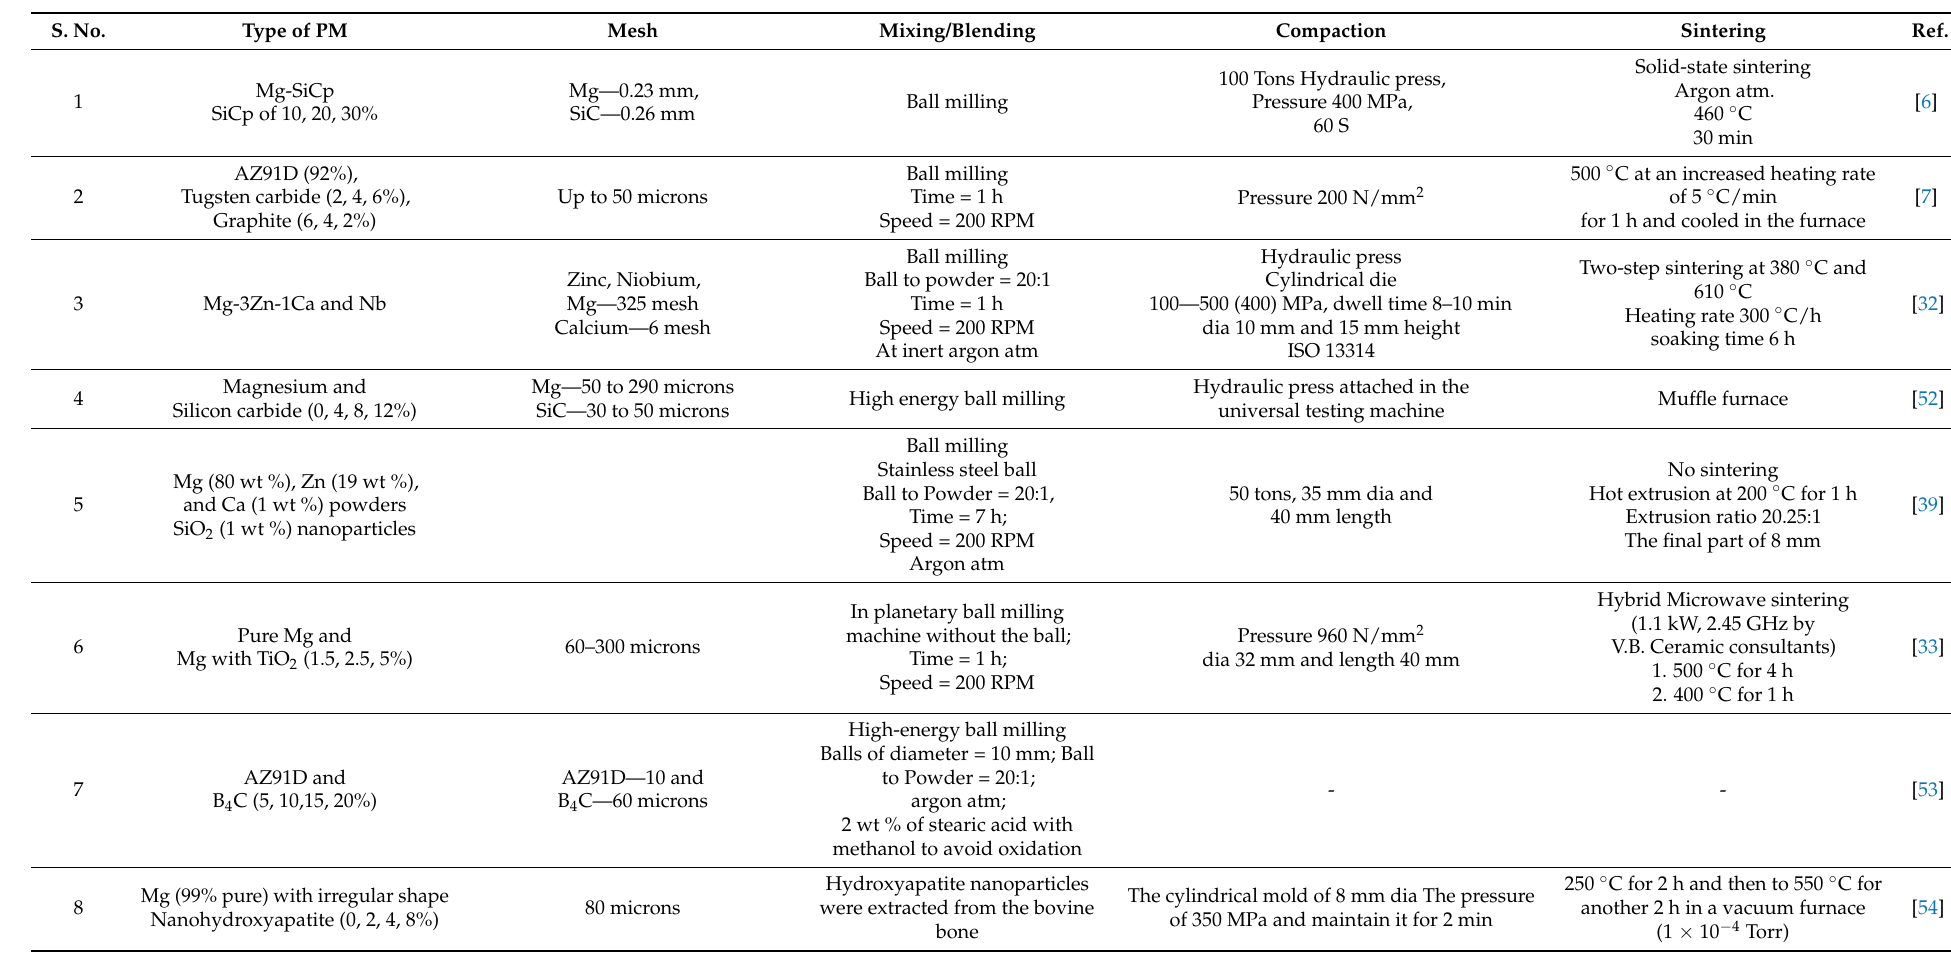
Table 1. Process parameters of conventional compaction and sintering of Mg